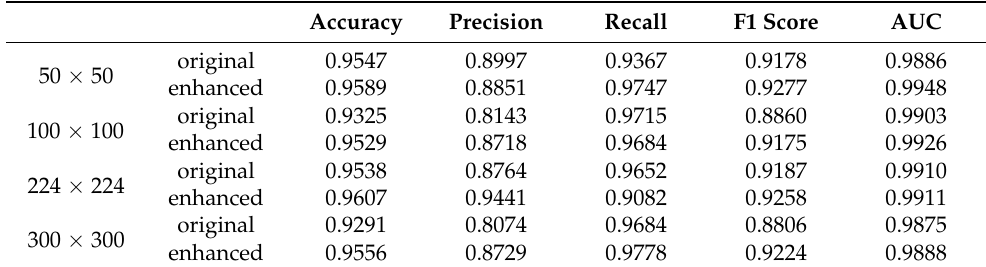
Table 6, which showing the same trend as Table 4; Table 5, which inflects the effect of contrast enhancement methods. Table 5. Summary of performance of different input shapes with our proposed model and loss